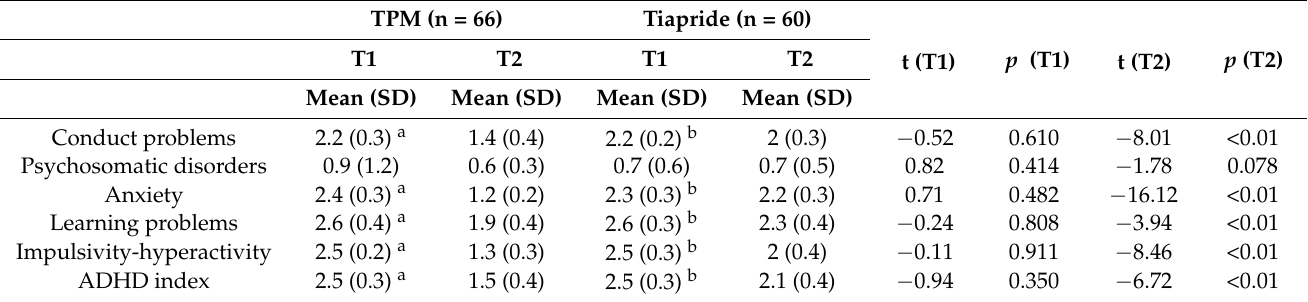
Table 4 list the results of the CBCL of the TPM and tiapride groups. There